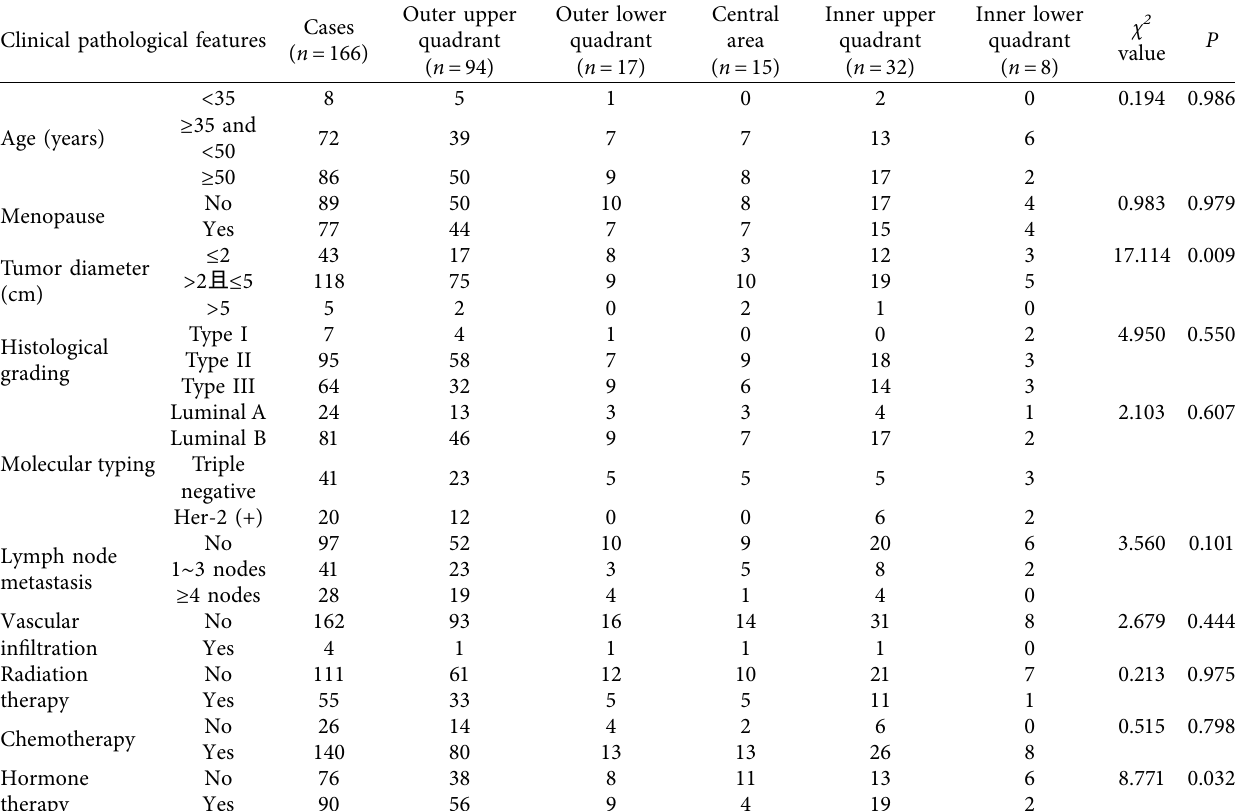
Table 1: Clinical pathological features of